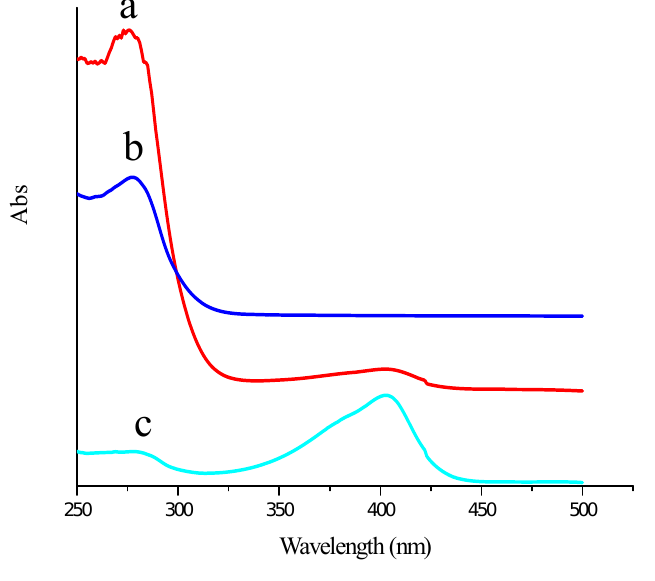
Figure 3. UV-VIS of ( a ) EVC-AFP Ab2; ( b ) AFP Ab2-HRP; ( c ) HRP,